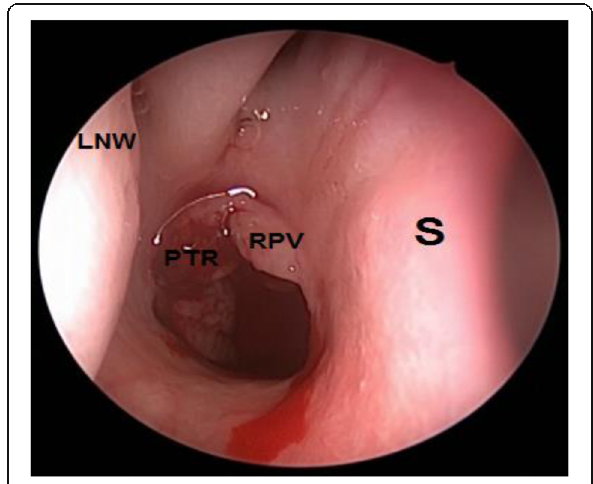
Fig. 4 Intraoperative transnasal endoscopy demonstrating post debriding adenoid bed through the left choana